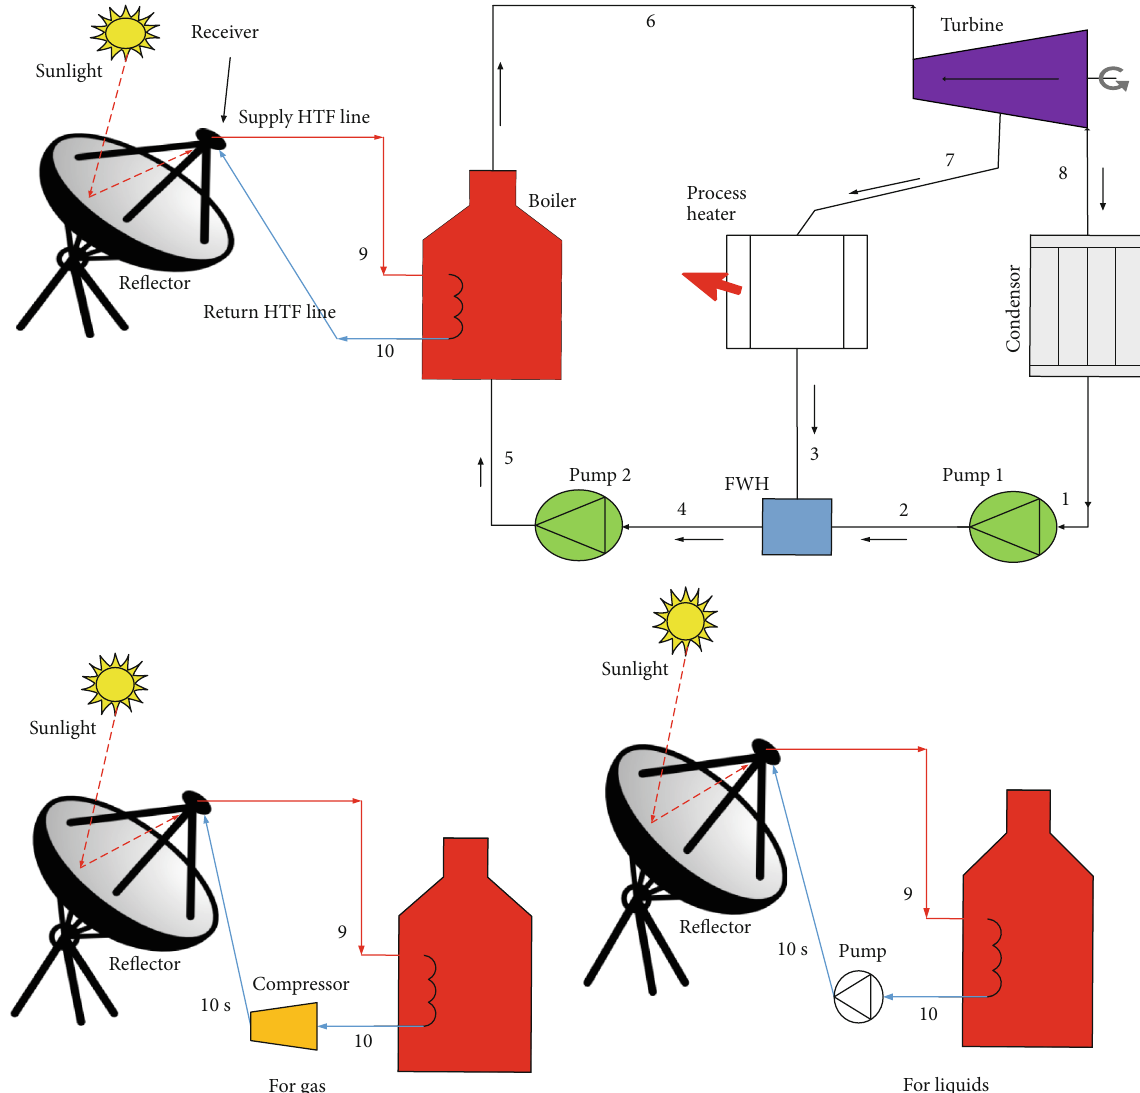
Figure 1: Schematic diagram of the proposed parabolic dish solar integrated cogeneration